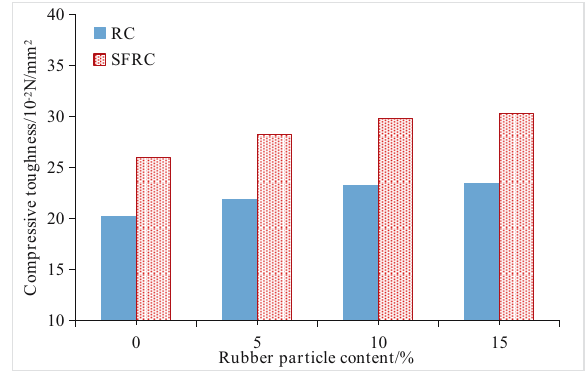
Figure 13: Compressive toughness of di ff erent concrete mix proportions.